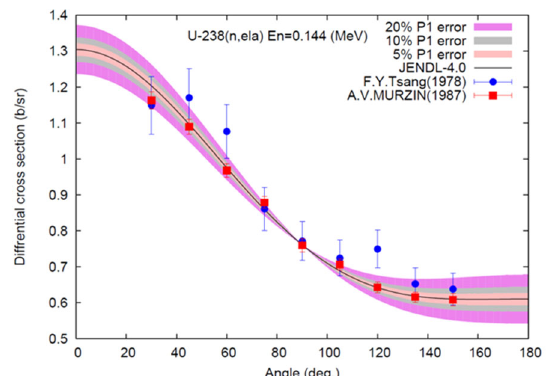
Fig. 6. Angular distribution of elastic scattering for 238